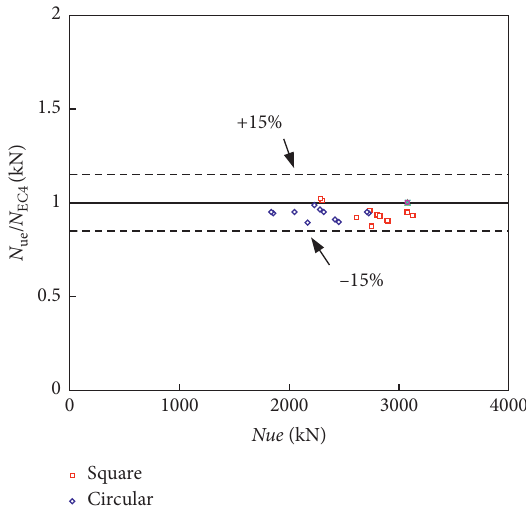
Figure 15: Comparison between test results and EC4